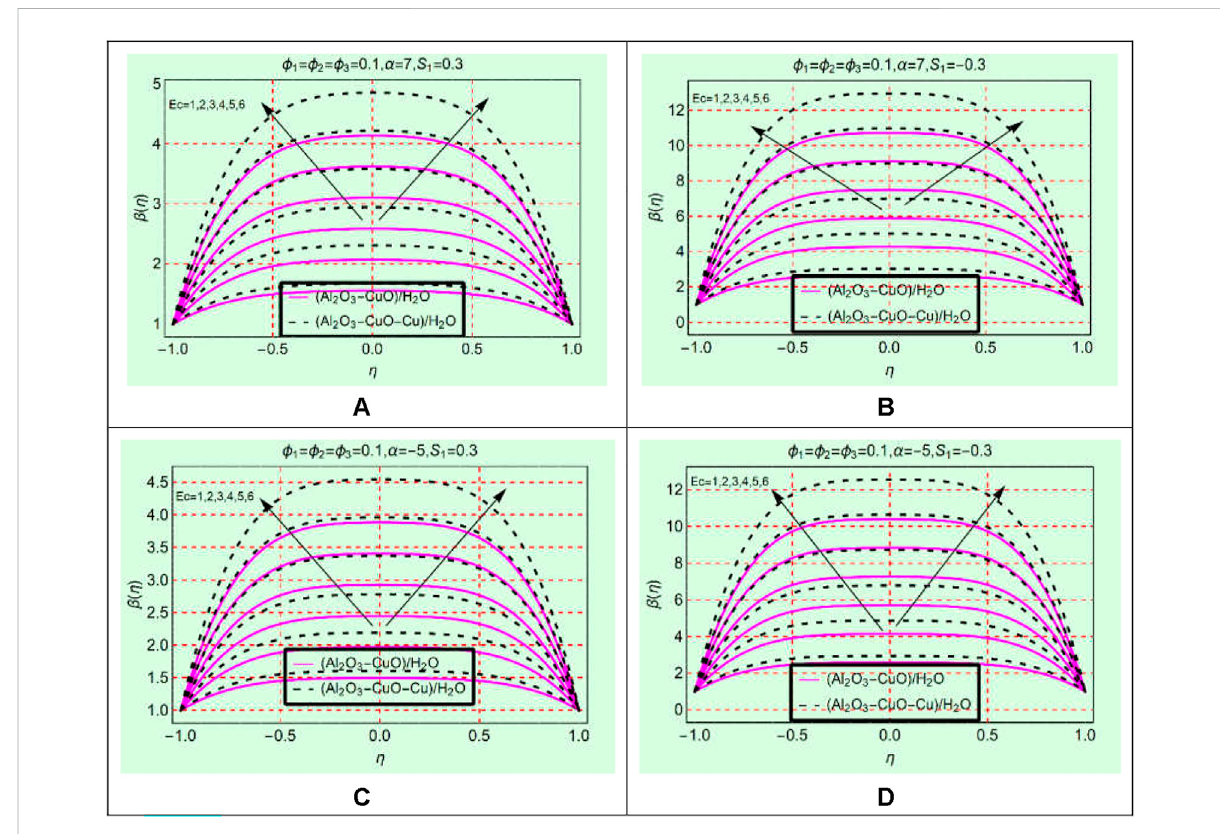
FIGURE 6 β ( η ) against Ec (A) stretching and divergent, (B) shrinking and divergent, (C) stretching and convergent, and (D) shrinking and